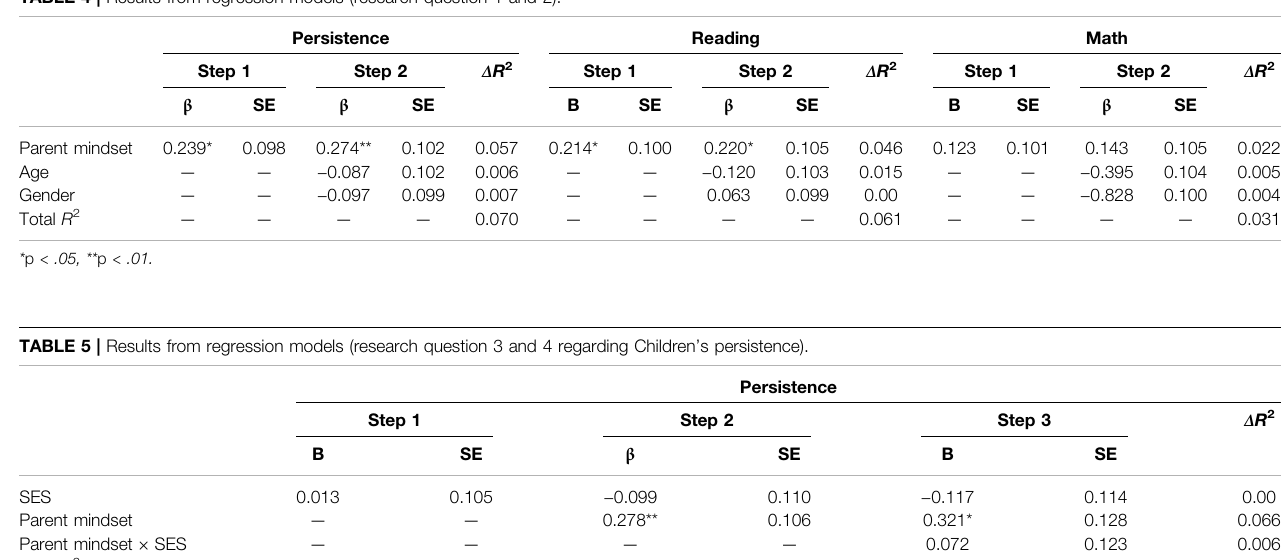
TABLE 4 | Results from regression models (research question 1 and 2).